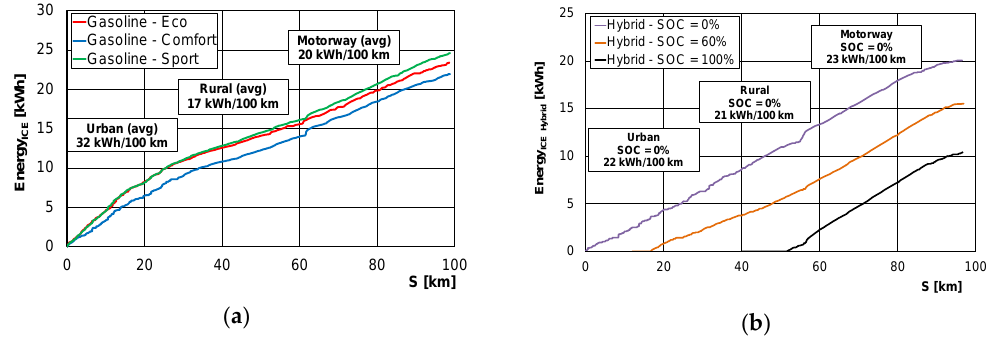
Figure 12. Accumulated energy demand of the combustion engine fitted in the conventional ( a ) and the hybrid vehicle ( b ) as divided into individual RDE test phases. Energies 2020 , 13 , x FOR PEER REVIEW